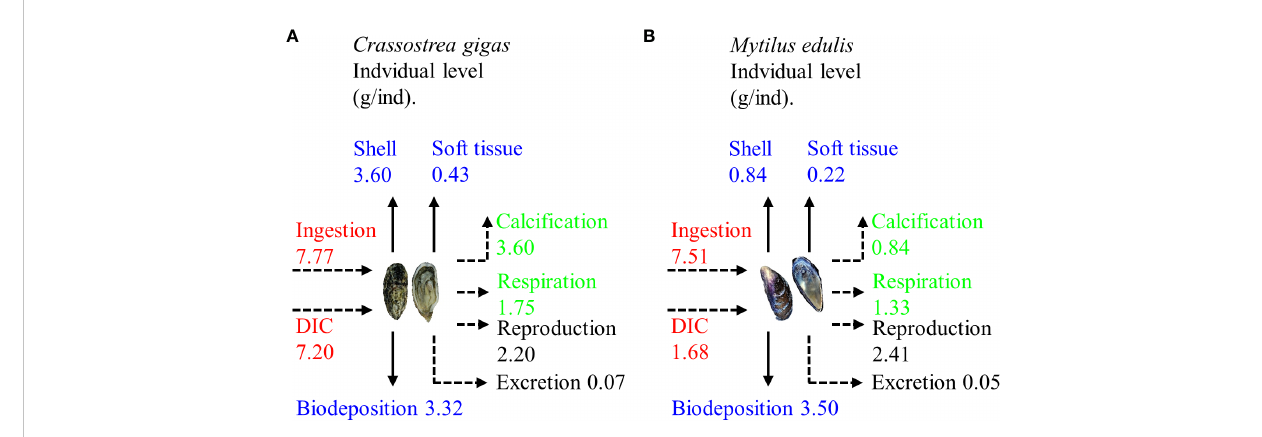
FIGURE 5 Carbon budget in one growth cycle of (A) Crassostrea gigas and (B) Mytilus edulis (Modi fi ed from Ren, 2014). DIC, dissolved inorganic